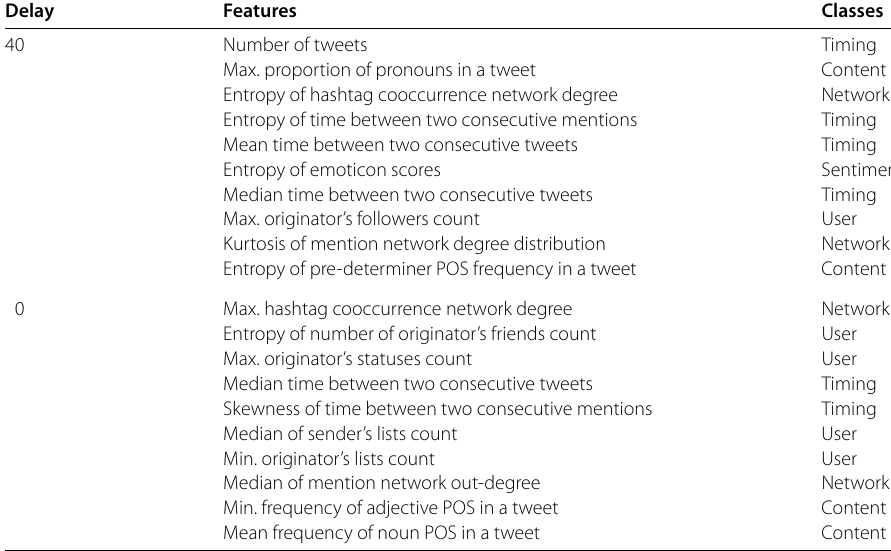
Table 3 Top 10 features for experiments with different values of